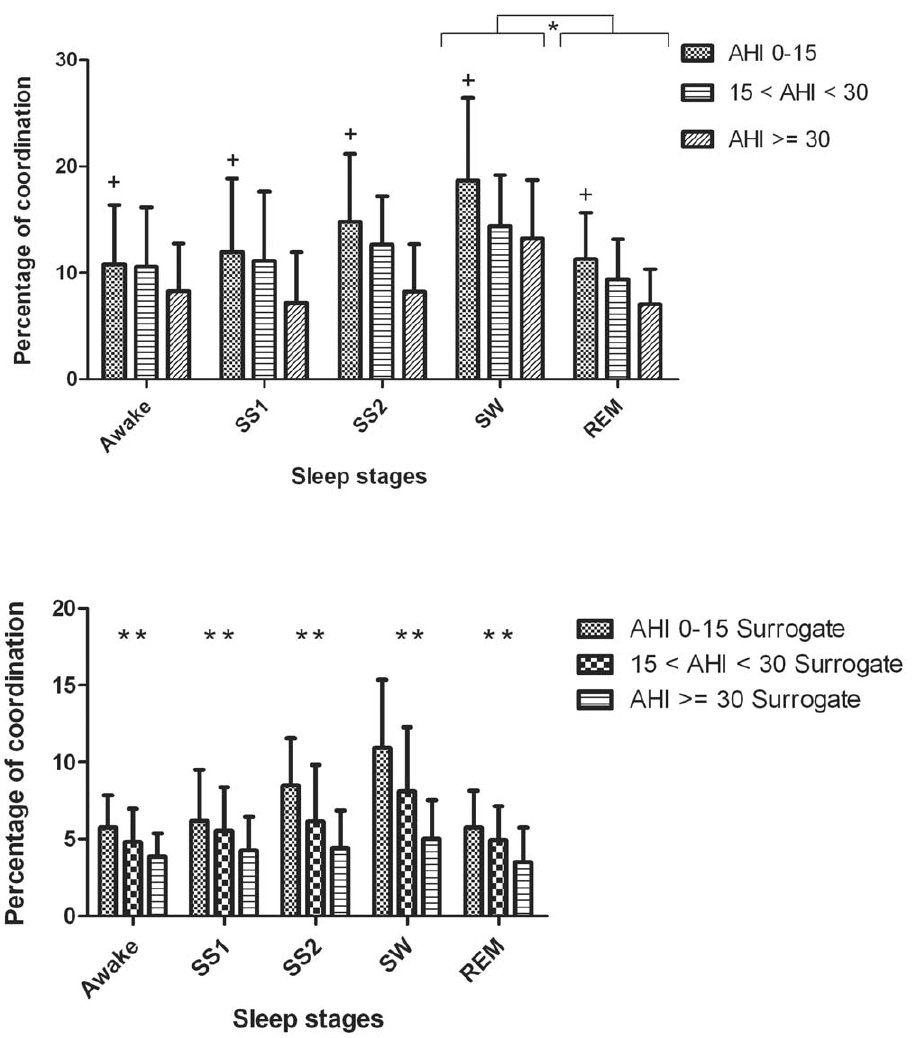
Figure 3. Group and sleep related comparison of percentage of coordination (%cordn, mean ± SD) using original (upper panel) and surrogate data (lower panel) from abdominal signal. The plus indicates that the differences in %cordn between the no/mild and severe OSA groups are significant ( p , 0.05). * ( p , 0.01) and ** ( p , 0.001) indicates the significant differences in %cordn between the SW and REM sleep stages and between the original and surrogate data